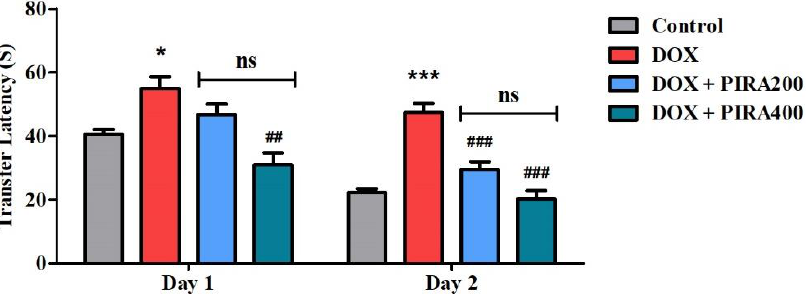
Figure 1. Effect of piracetam (PIRA) on day 1 and day 2 transfer latency (s) of doxorubicin (DOX)- induced rats using an elevated plus-maze test. The results are expressed by mean ± SEM ( n = 7). A one-way ANOVA [ F (3,24) = 10.20, p < 0.001 for day 1 and F (3,24) = 26.96, p < 0.001 for day 2 of the